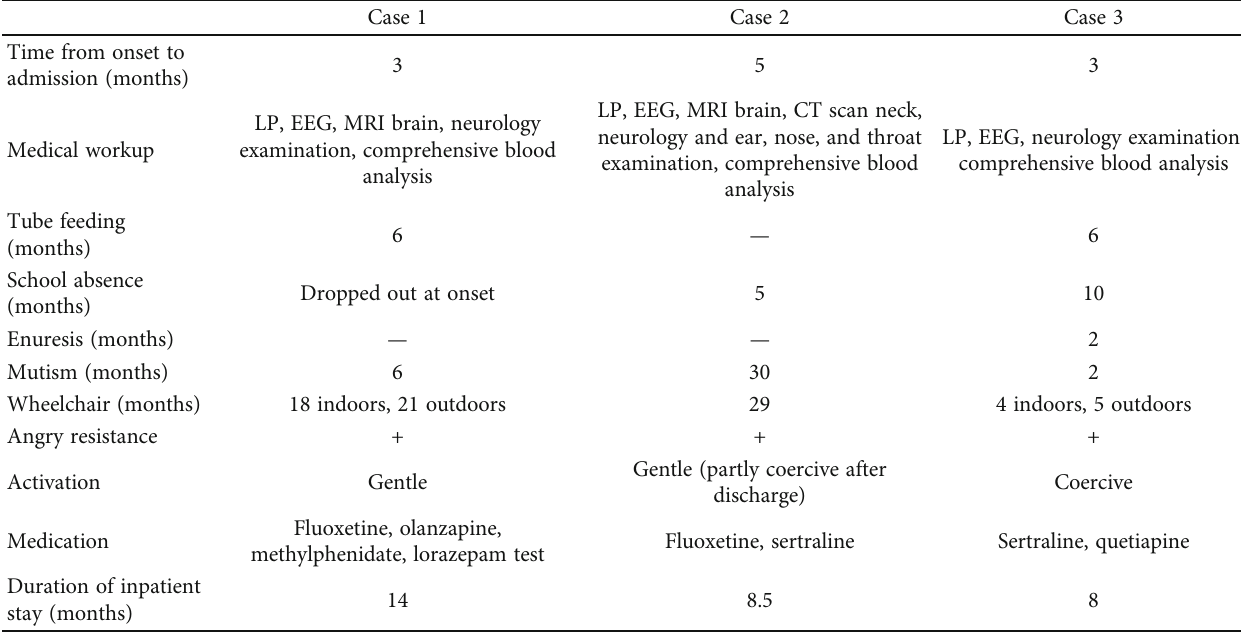
Table 3: Features of inpatient